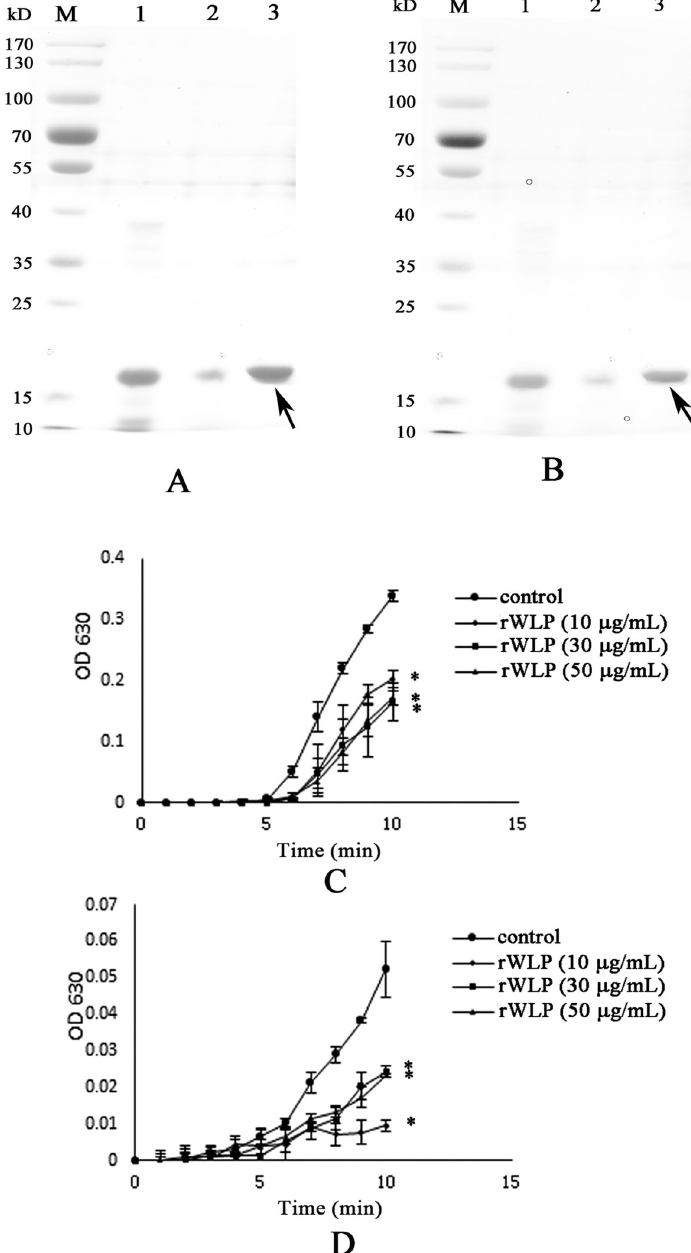
Fig 8. Binding ability of rWLP with calcite (A) and aragonite (B), and the crystallization rate inhibition of rWLP in calcite (C) and aragonite (D), respectively. Lane M, protein marker; Lane 1, pure rWLP; Lane 2, the supernatant of the solution after that the rWLP was precipitated by calcium carbonate crystals; Lane 3, the rWLP released from the precipitated calcium carbonate crystals; The Data of C and D represent mean ± SD (n = 3). � , p < 0.01. to be studied in more detail. We noted that the rWLP had relatively strong effects on the mor- phology of aragonite and the polymorph of calcite, suggesting the selective action of rWLP for different calcium carbonate crystals. In the shell of M . coruscus , the myostracum and the nacre are composed of aragonite with the same polymorph but different morphology, and WLP was